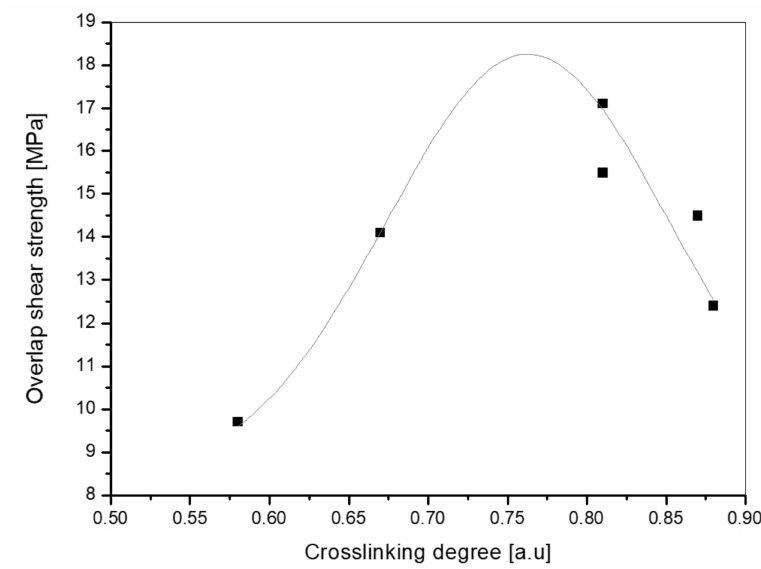
Figure 7. Influence of cross-linking degree ( α , DSC measurements) of thermally cured SATs on overlap shear strength for aluminum–SAT–aluminum overlap